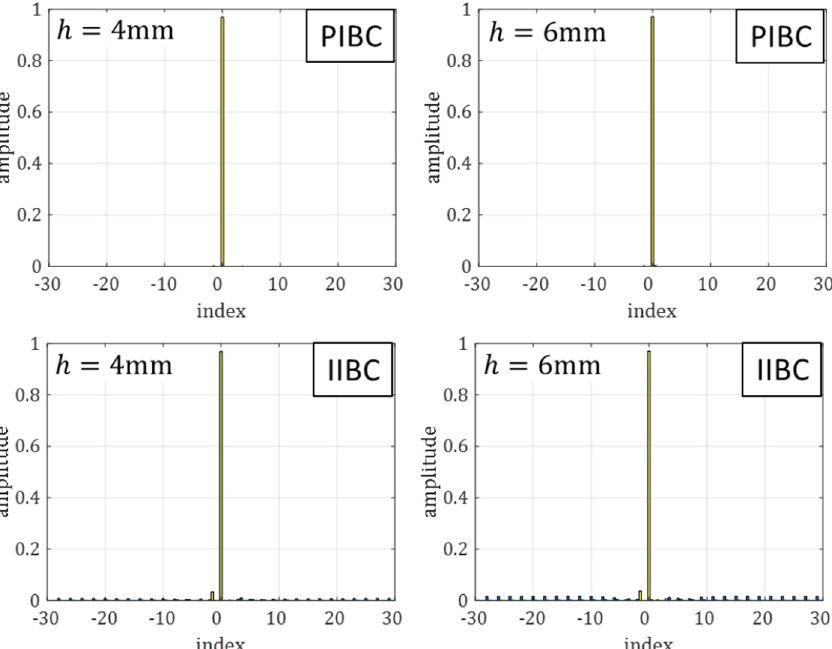
Fig. 6. Amplitude of the Floquet wave spectrum of the re fl ected electric fi eld for different heights of the dielectric with a permittivity of the dielectric of e r ¼ 2 : 5 for an TE-polarized incident wave at u i ¼ 0 ° and a TM-polarized re fl ected wave at u r ¼ (cid:3) 20 ° for: (top) the PIBC solution in (5) and (bottom) the PIBC obtained by removing from the IIBC in (4) the contribution of the grounded slab evaluated at the incidence wavenumber.